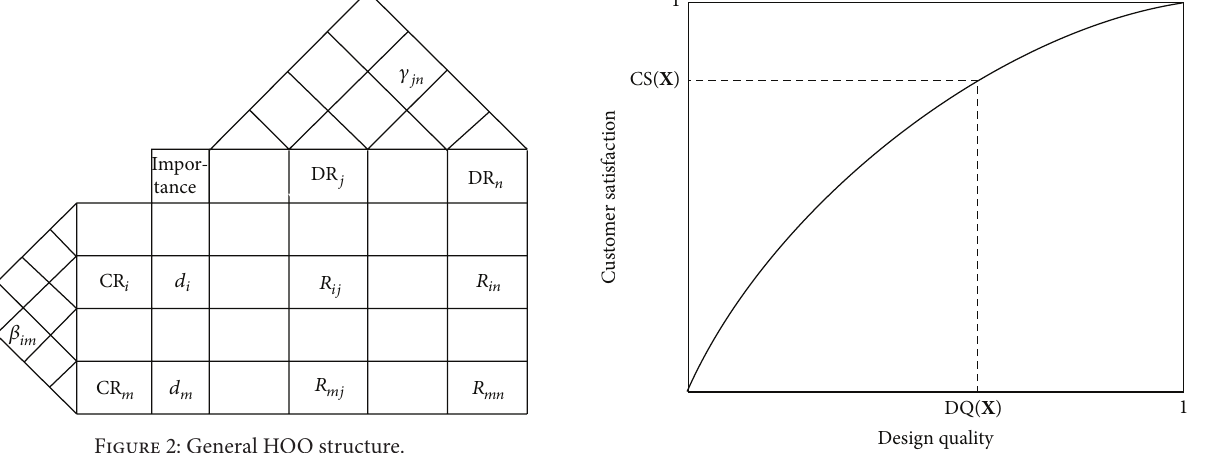
Figure 3: Functional curve for customer satisfaction (CS) and design quality